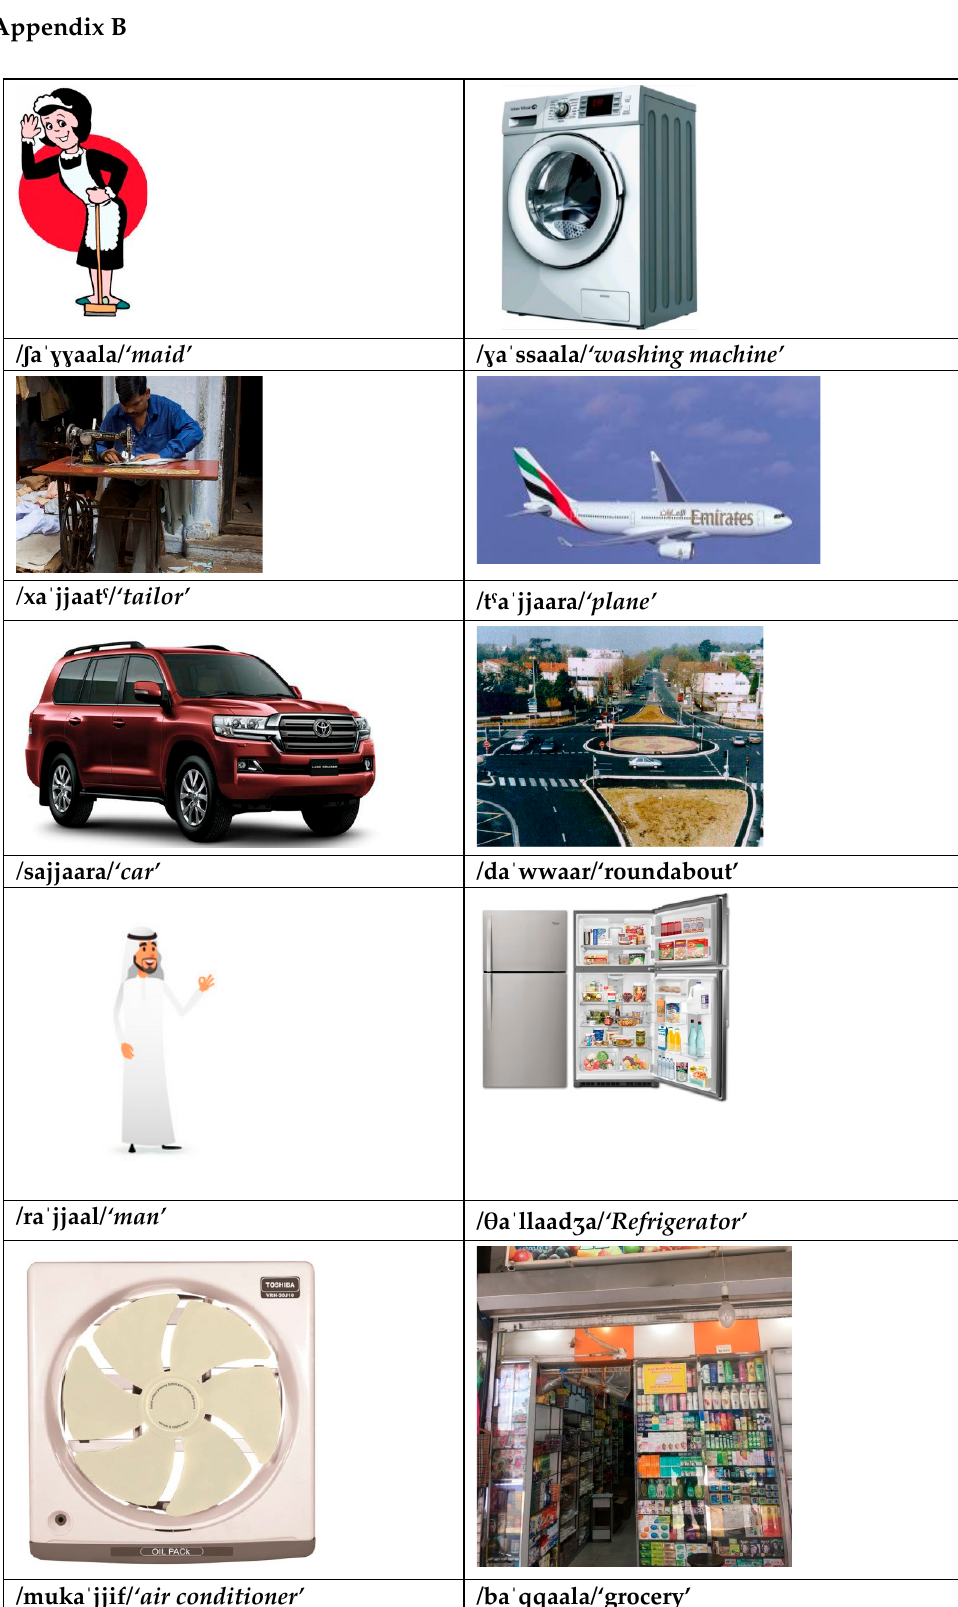
Figure A2. The test where the pictures featuring geminates were shown. Figure A1. The test where the pictures featuring geminates were